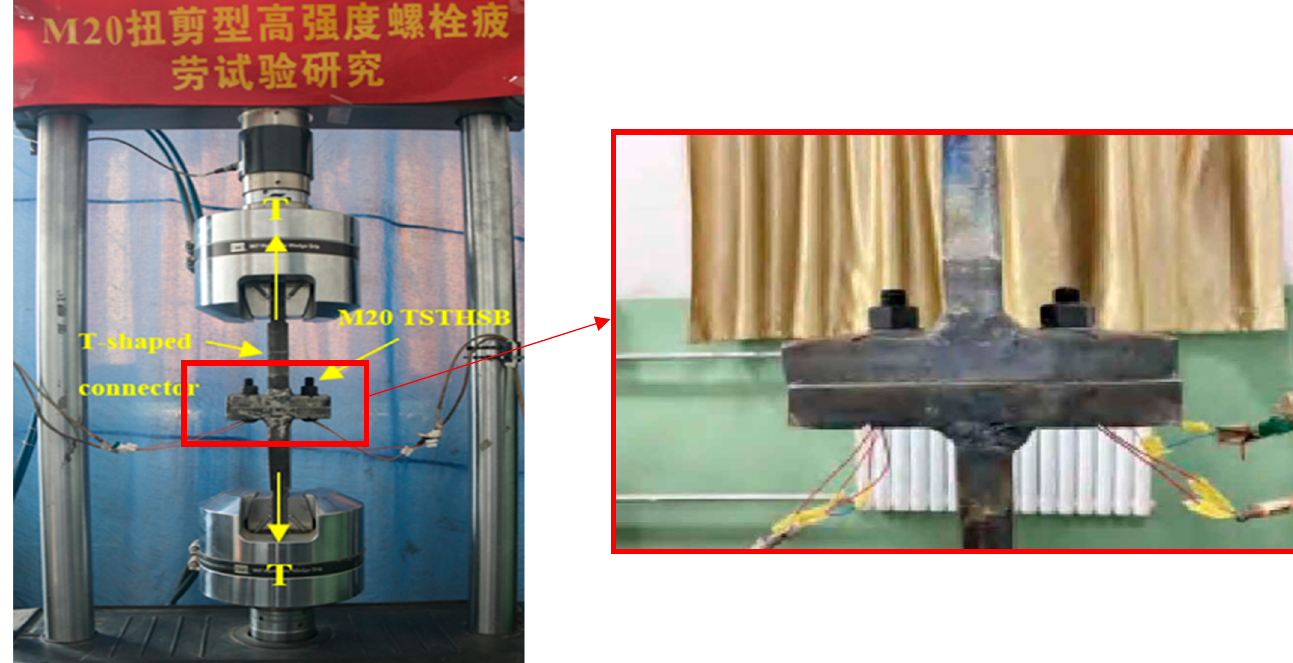
Figure 5. Photograph of constant ‐ amplitude fatigue tests.